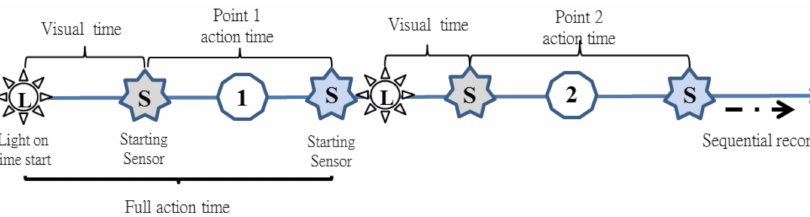
Figure 4. Measurement procedure for the six-point footwork drills and tournament training